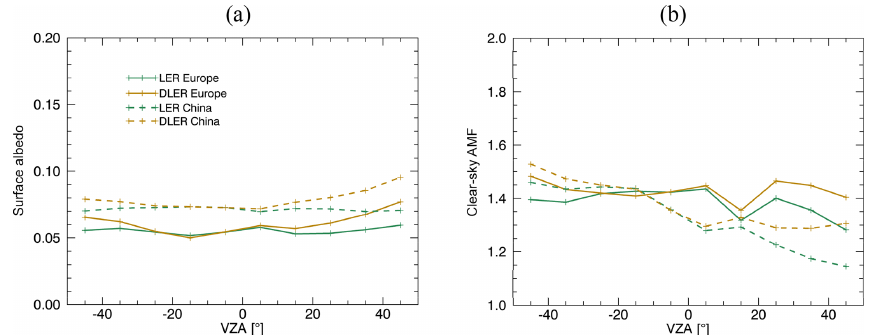
Figure 2. Comparison of GOME-2 LER climatology (Tilstra et al., 2017) and GOME-2 DLER data (a) and the impact on the clear-sky AMFs (b) over western Europe (44–53 ◦ N, 0–7 ◦ E) and eastern China (21–41 ◦ N, 110–122 ◦ E) as a function of VZA in February 2010 (VZAs are negative for observations on the eastern side of the orbit